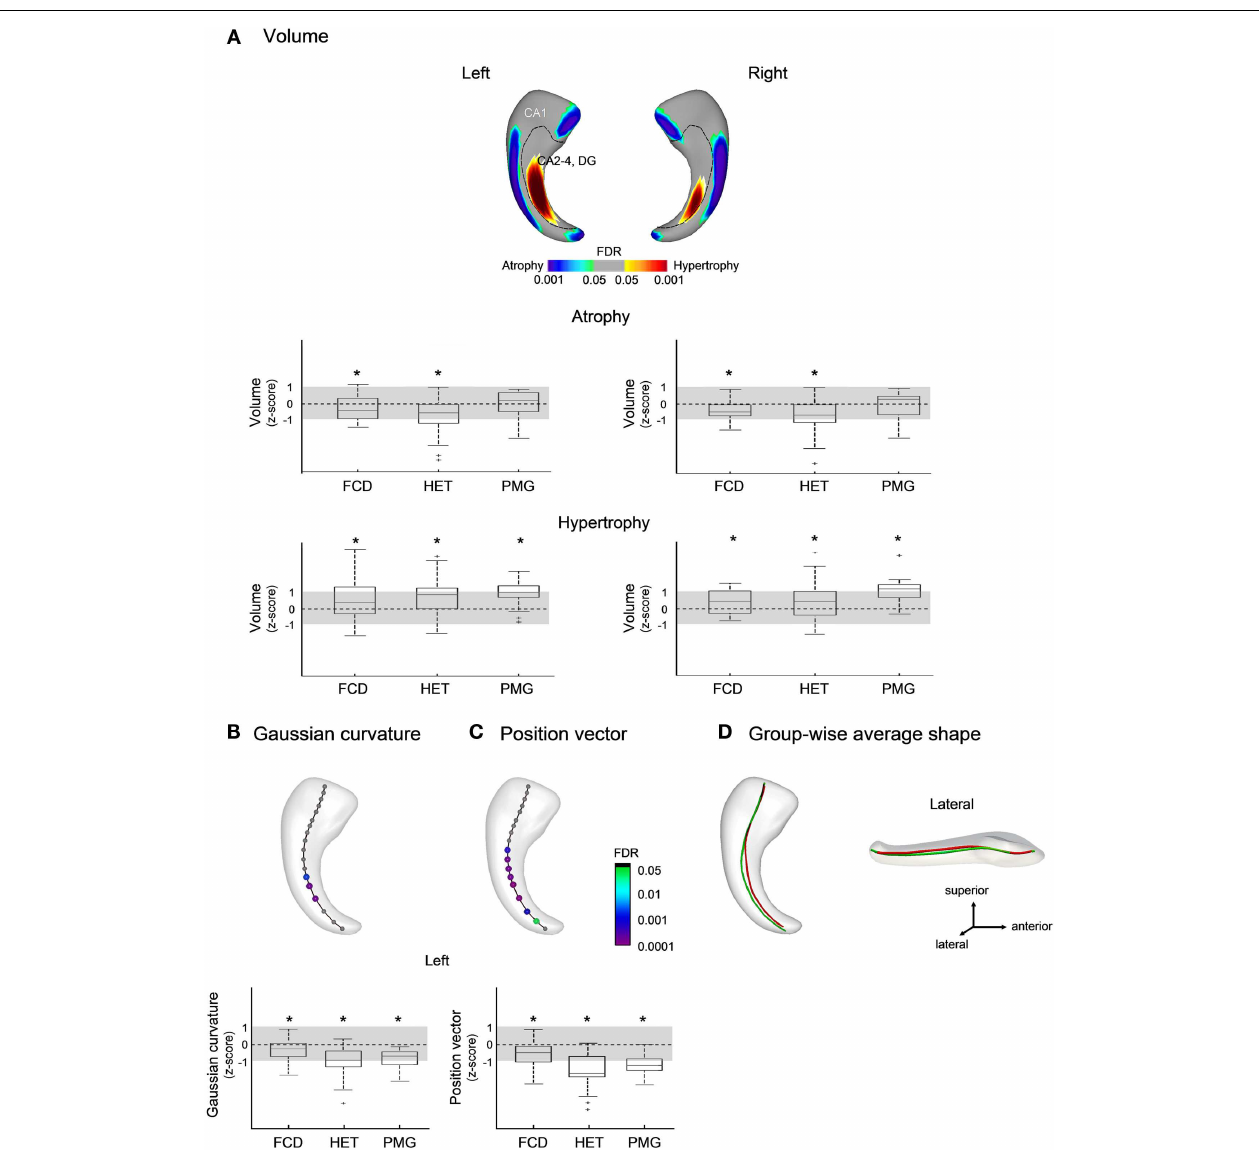
FIGURE 3 | Group comparisons between patients with malformations of cortical development (MCD) and healthy controls for: (A) volume; (B) Gaussian curvature; and (C) position vectors; in (D), the group-wise mean meridian axis shows a flattening (i.e . , decrease in curvature) of the body along with a shift from the lateral to medial direction with respect